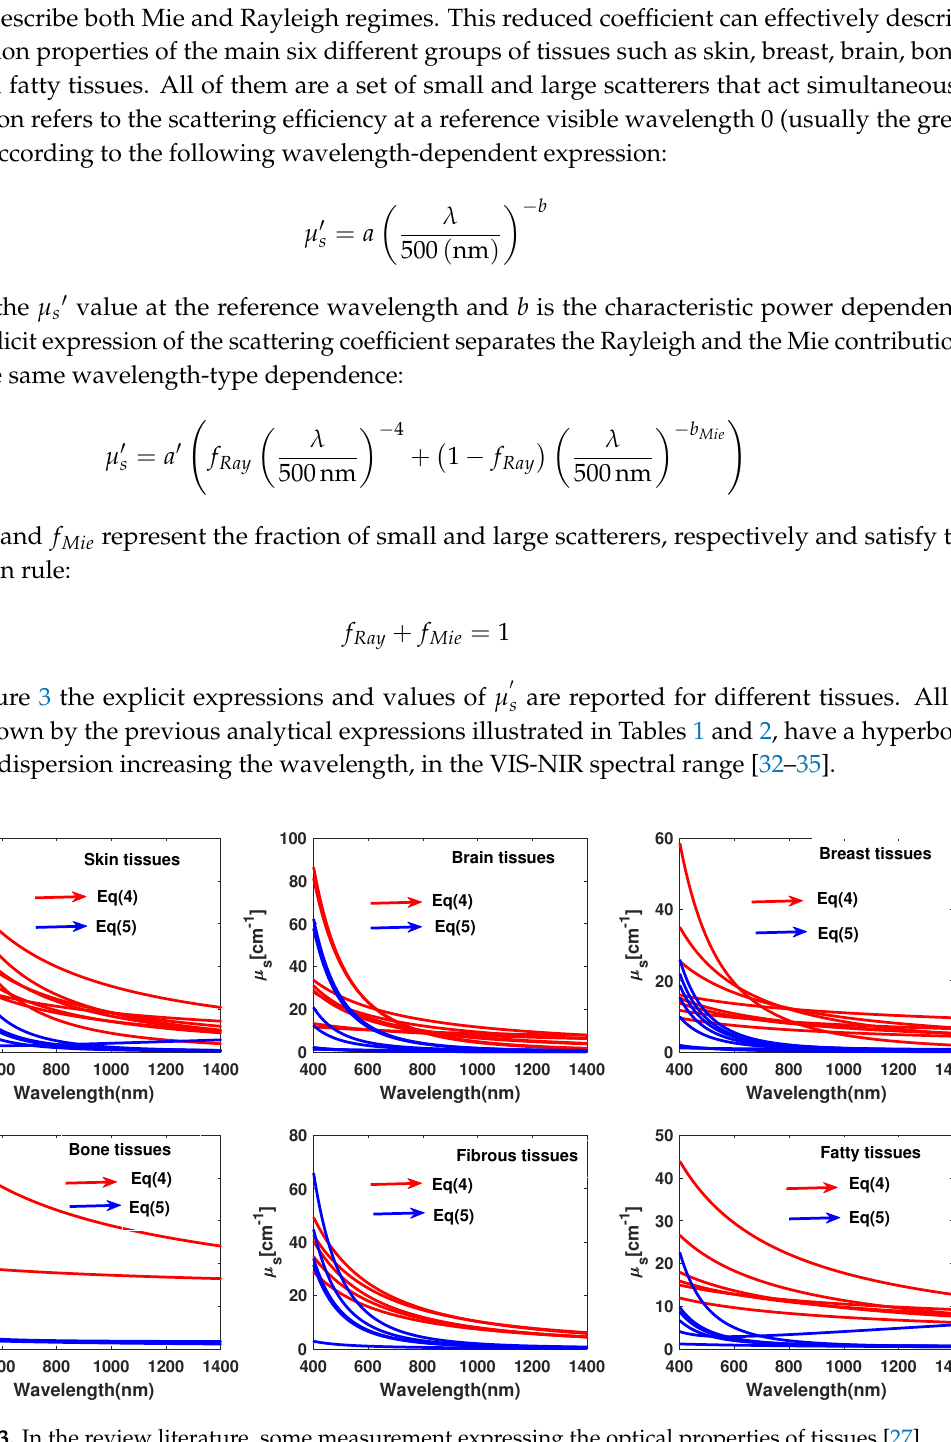
Figure 3. In the review literature, some measurement expressing the optical properties of tissues